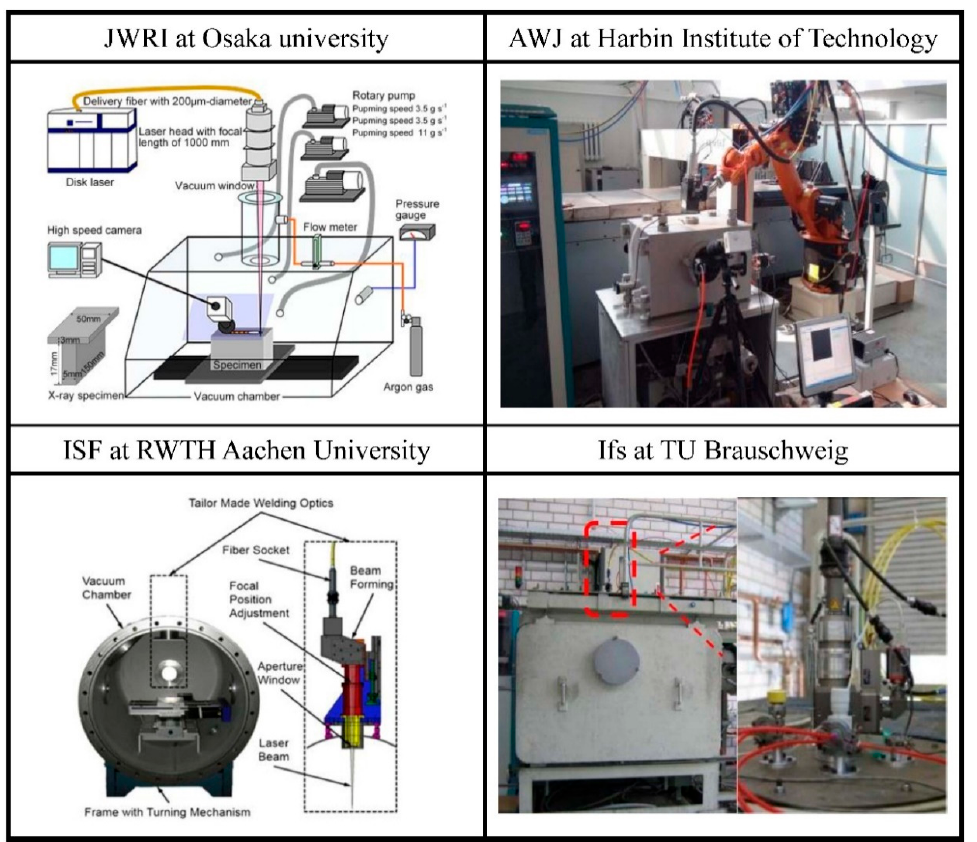
Figure 2. The equipment of laser welding under vacuum. Reproduced with permission from [31], Springer, 2016; Reproduced with permission from [33], Laser Institute of America, 2011; Reproduced with permission from [44], Taylor & Francis, 2014.